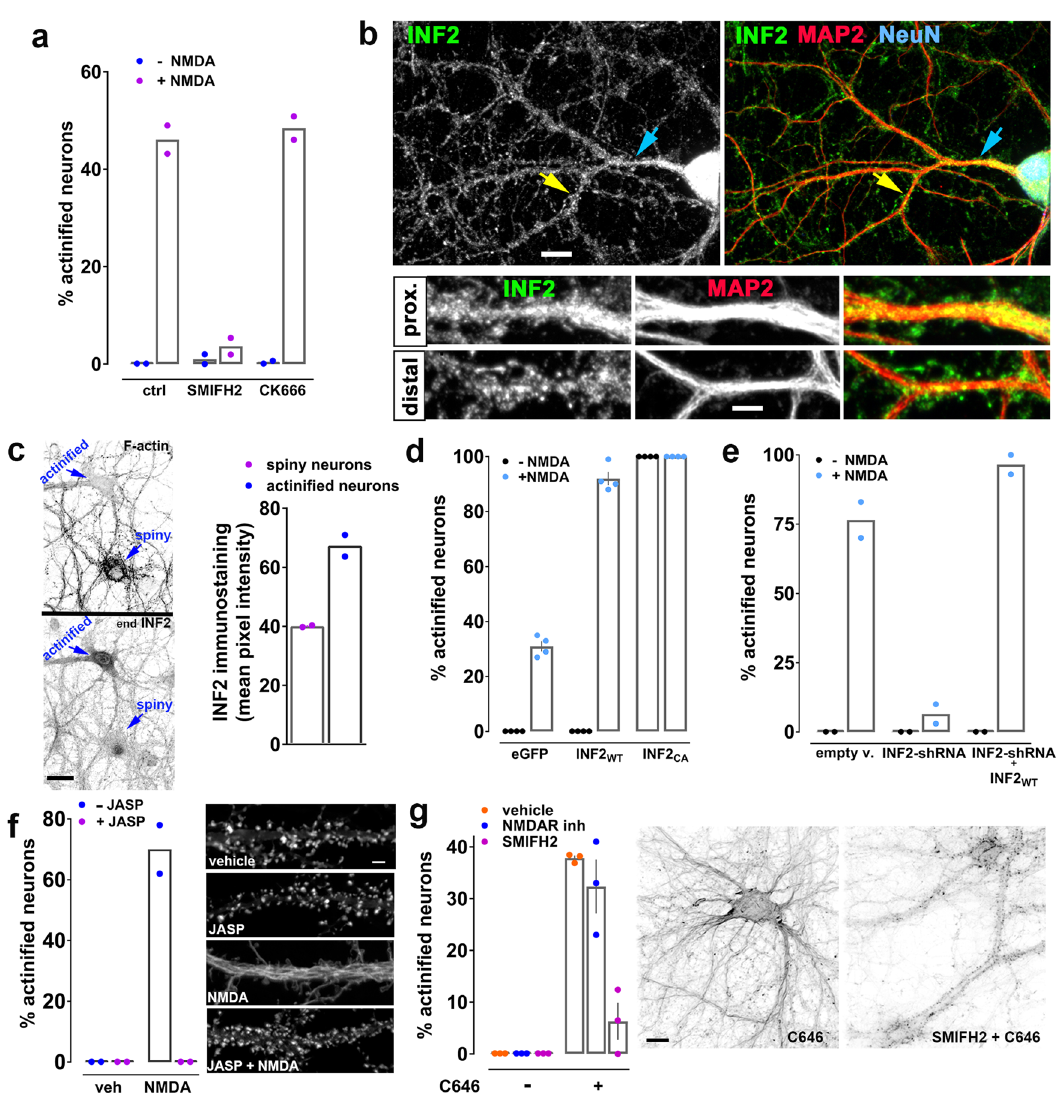
Fig.5|Actini fi cationrequiresINF2andF-actindepolymerization.a SMIFH2,not CK666,inhibitsactini fi cation. n =2independentexperiments;two-wayANOVA[( −